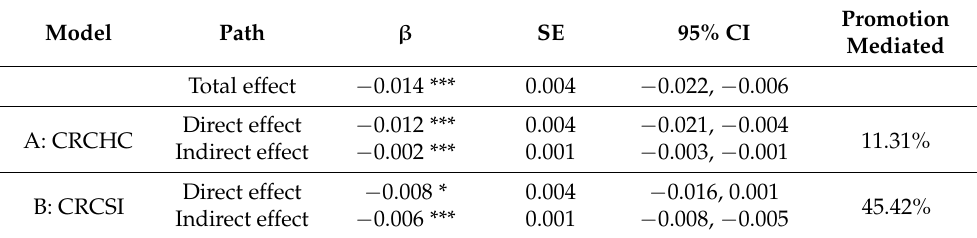
Table 6. Bootstrap analysis of the mediation